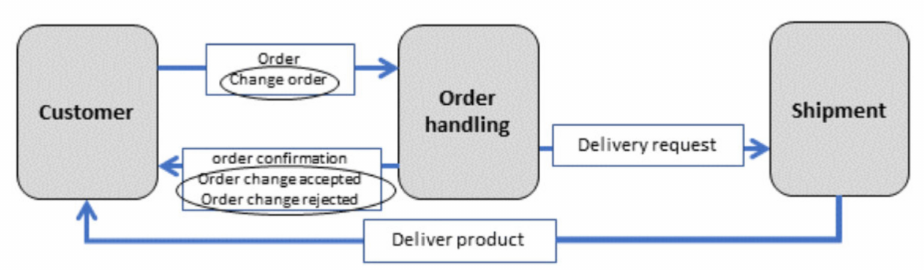
Figure 8. Subject-Interaction Diagram including a change of order.